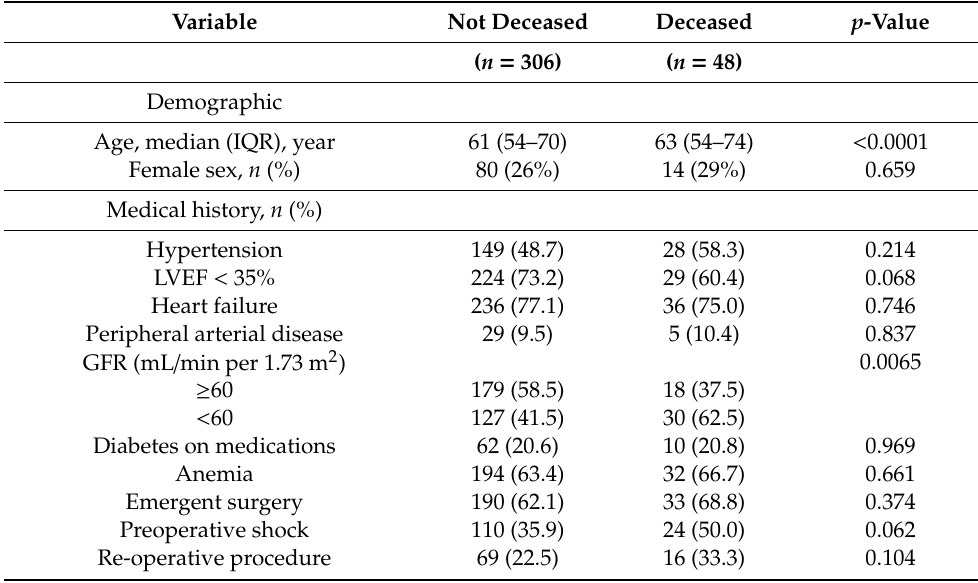
Table 2. Baseline and perioperative characteristics of high-risk patients, as defined by a Cardiac Anesthesia Risk Evaluation score of